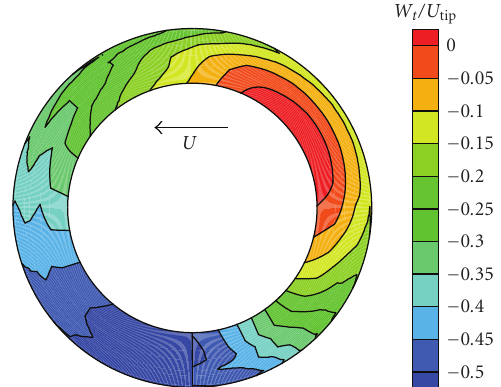
Figure 6: Tangential velocity component section e.